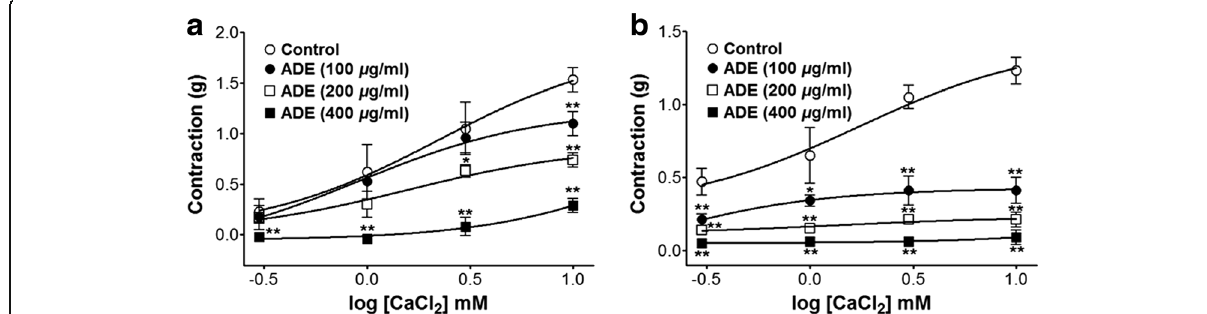
Fig. 4 Inhibitory effect of ADE (100 – 400 μ g/ml) on the contraction induced by extracellular Ca 2+ in endothelium-denuded rat thoracic aorta rings pretreated by PE (1 μ M) ( a ) or KCl (60 mM) ( b ) in the presence or absence (not pre-treated control) of ADE. Values are expressed as mean ± SEM